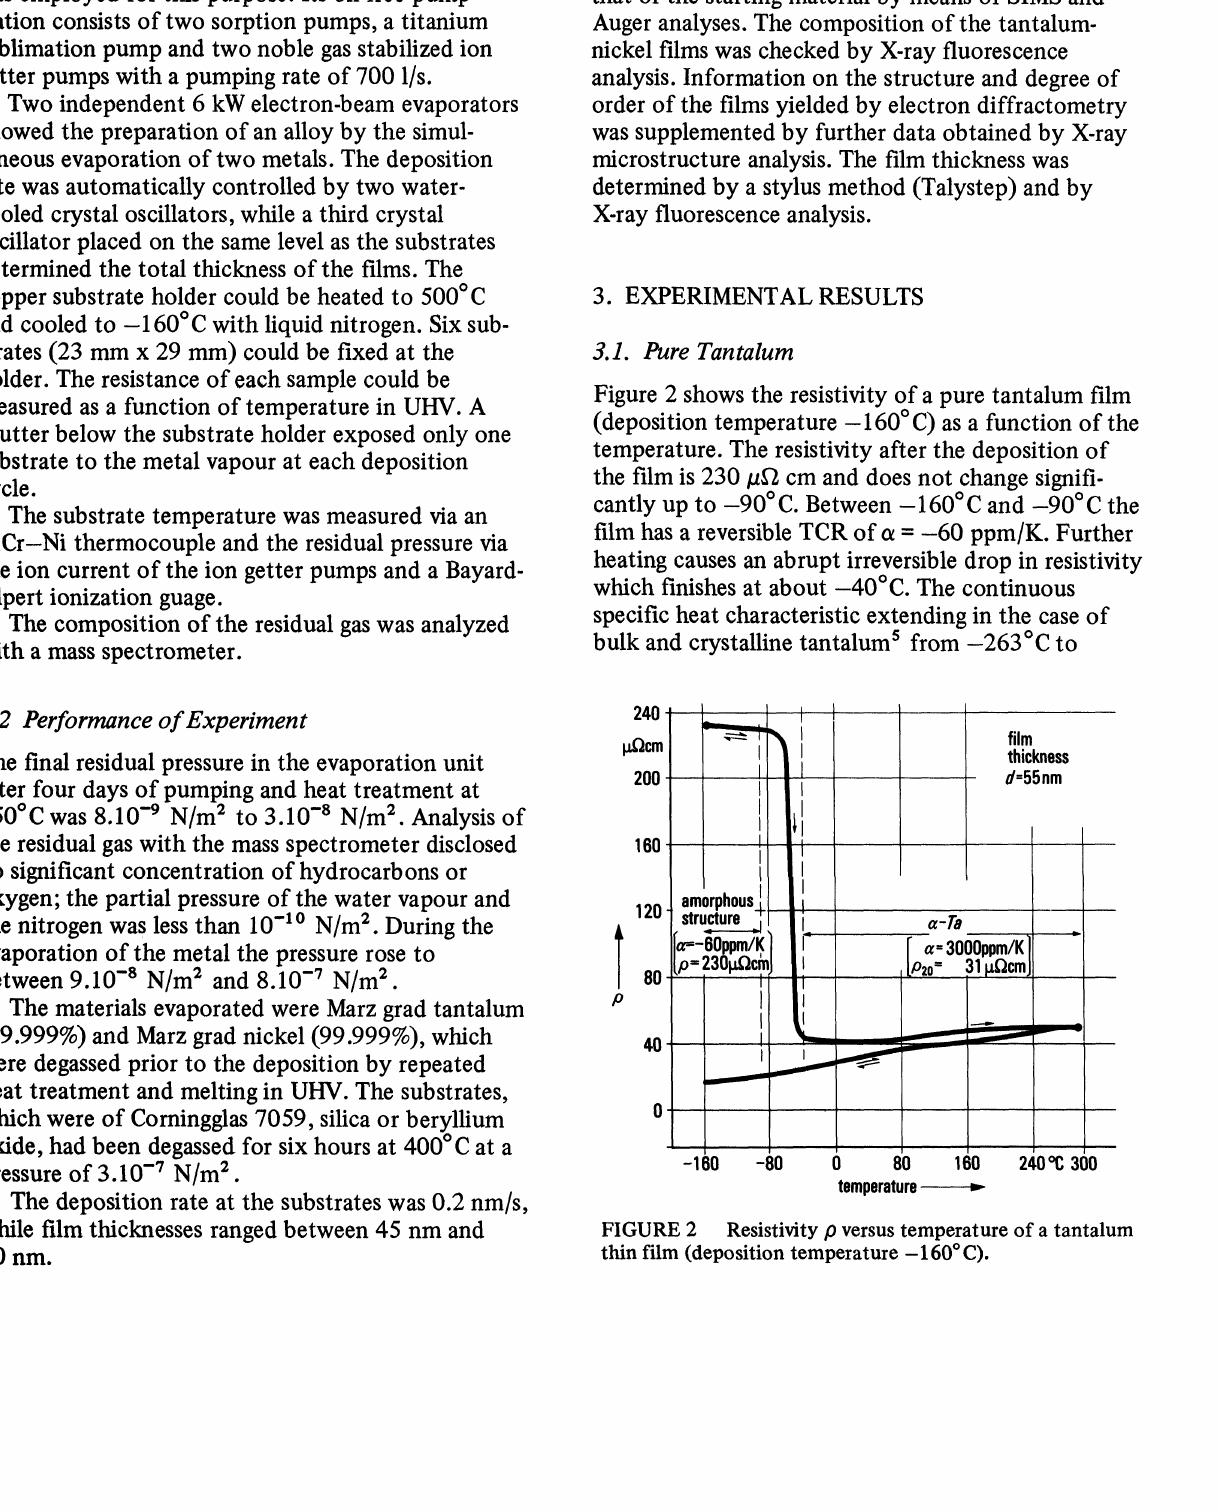
Resistivity/9 versus temperature of a tantalum thin film (deposition temperature -160